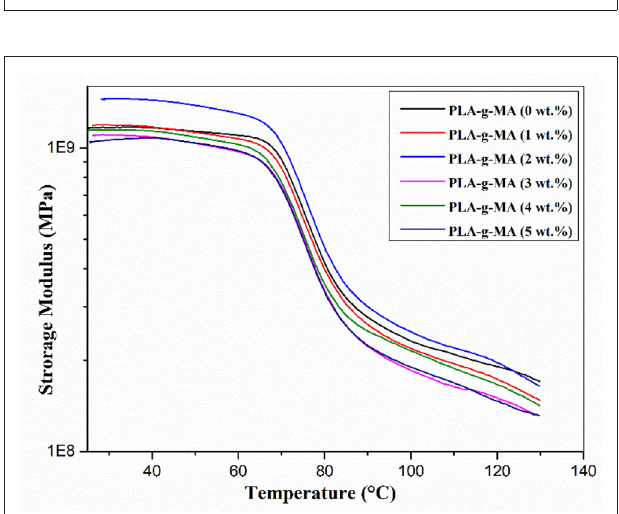
FIGURE 10 | Storage modulus as a function of the temperature of PLA/PA12 blends with varying content of